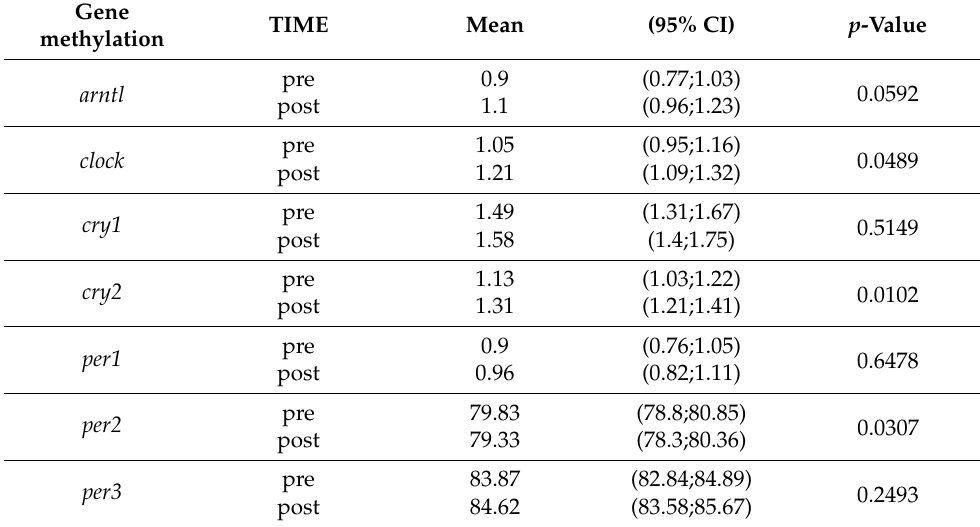
Table 2. Gene-specific clock methylation means (pre and post 3-week BWRP).